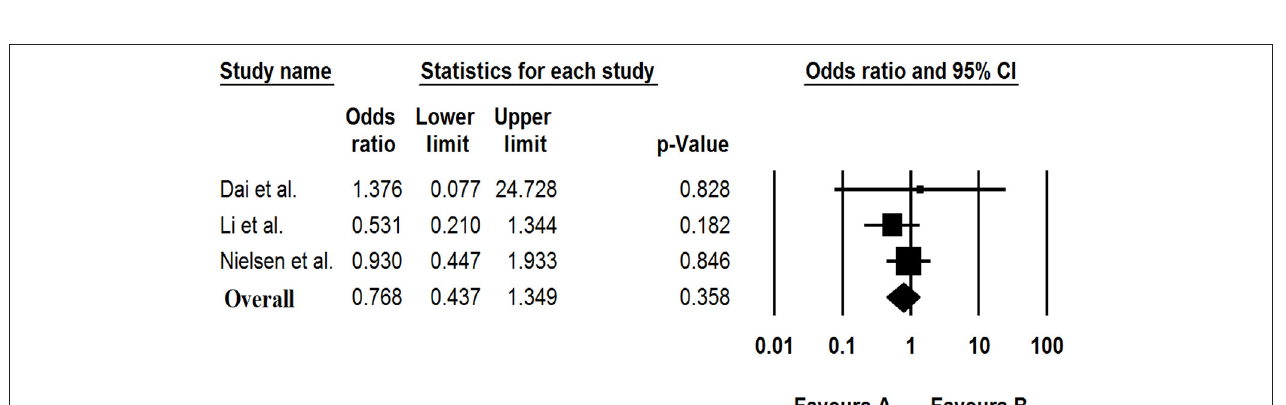
FIGURE 5 | Forest plot of odds ratios for the SAFV based on case-control studies.